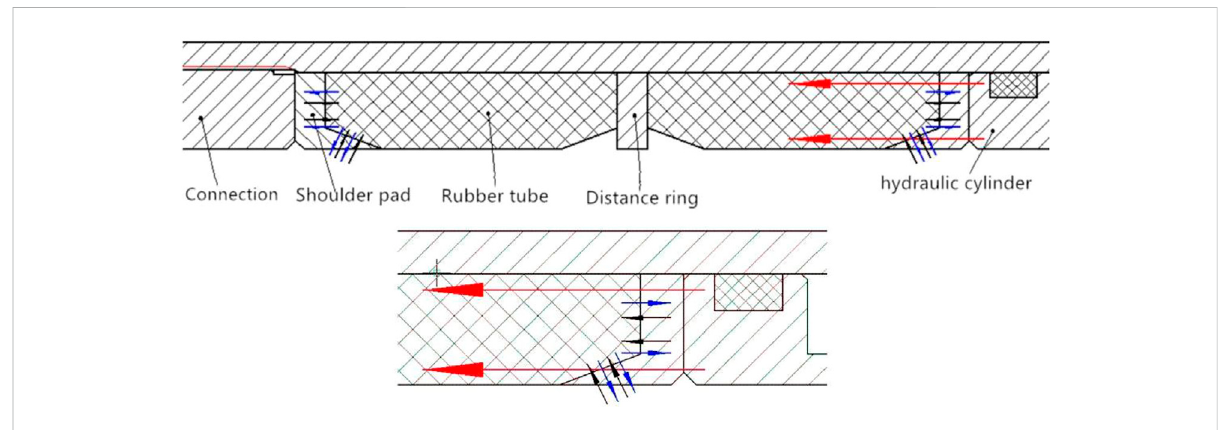
FIGURE 9 Schematic diagram of the rubber barrel structure.